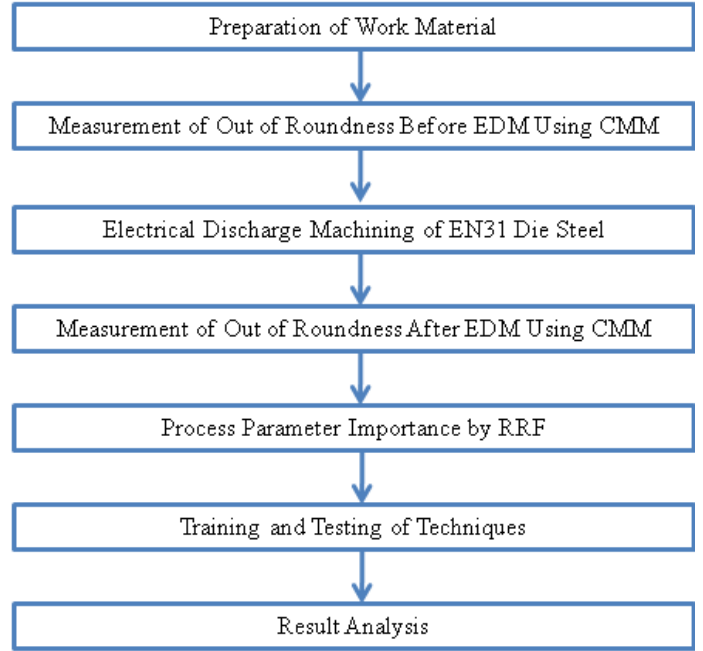
Figure 4. Methodology. Figure 4.